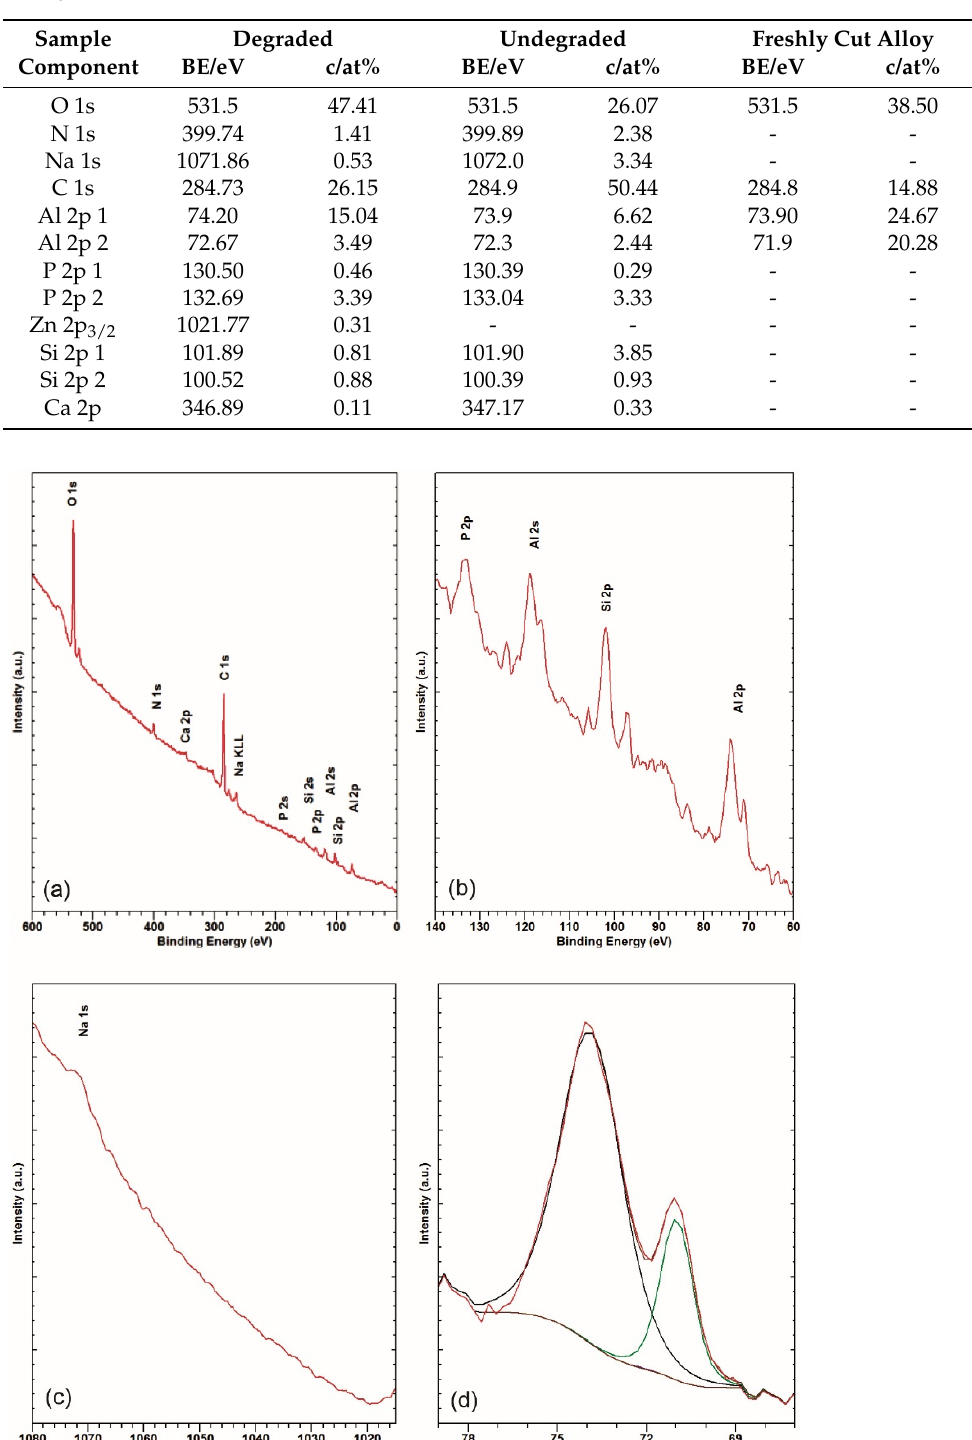
Table 2. XPS binding-energy values and the surface chemical composition according to the survey and high-resolution XPS spectra of the degraded area, the undegraded area, and the area on the freshly cut surface.